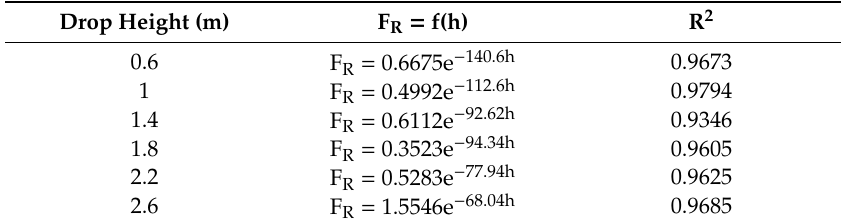
Table 1. Correlation between the impact force F R and the height h for the drop hammer weight of 60 kg with the use of the support system.